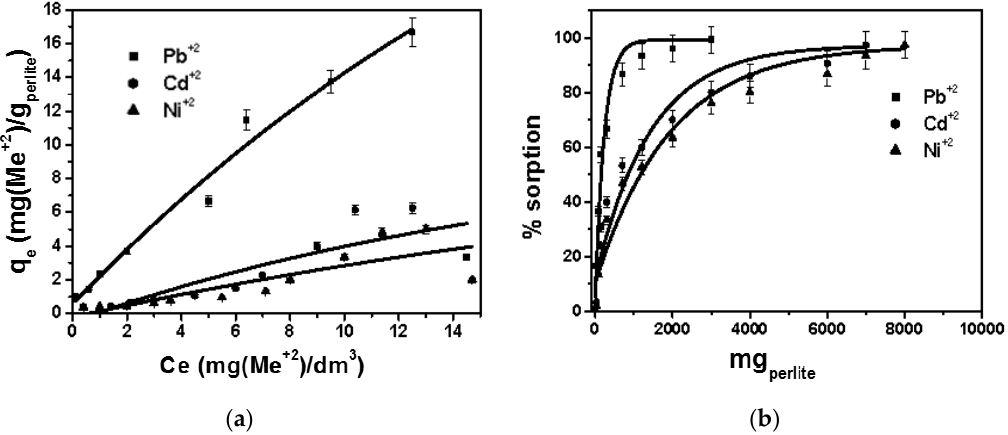
Figure 3. ( a ) Batch tests in de-mineralized water for a solution of lead, cadmium and nickel ions on perlite (1–2 mm bead size, 80 rpm, 15 mg(Me +2 )/dm 3 , 298 K); ( b ) effect of perlite dosage on the sorption.